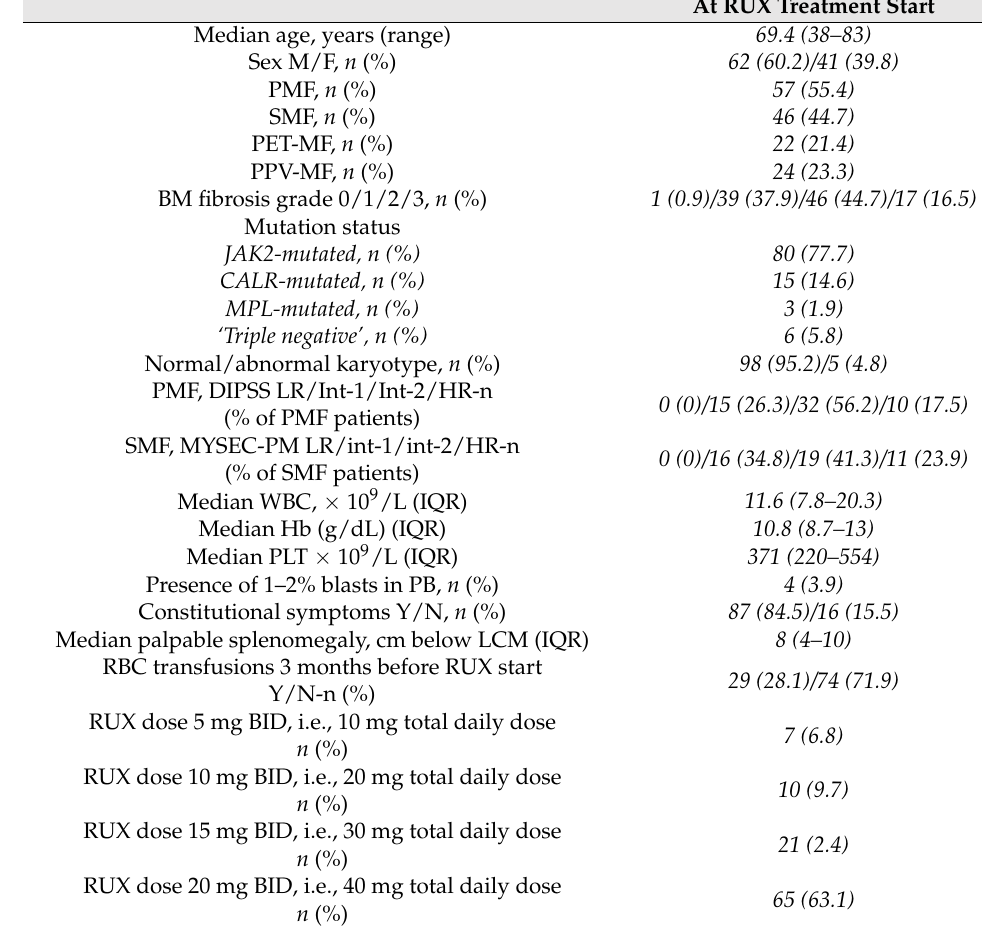
Table 1. Baseline characteristics of the 103 enrolled myelofibrotic patients. PMF: primary myelofibro- sis; SMF: secondary myelofibrosis; PET: post-essential thrombocythemia; PPV: post-polycythemia vera; LCM: lower costal margin; RUX: